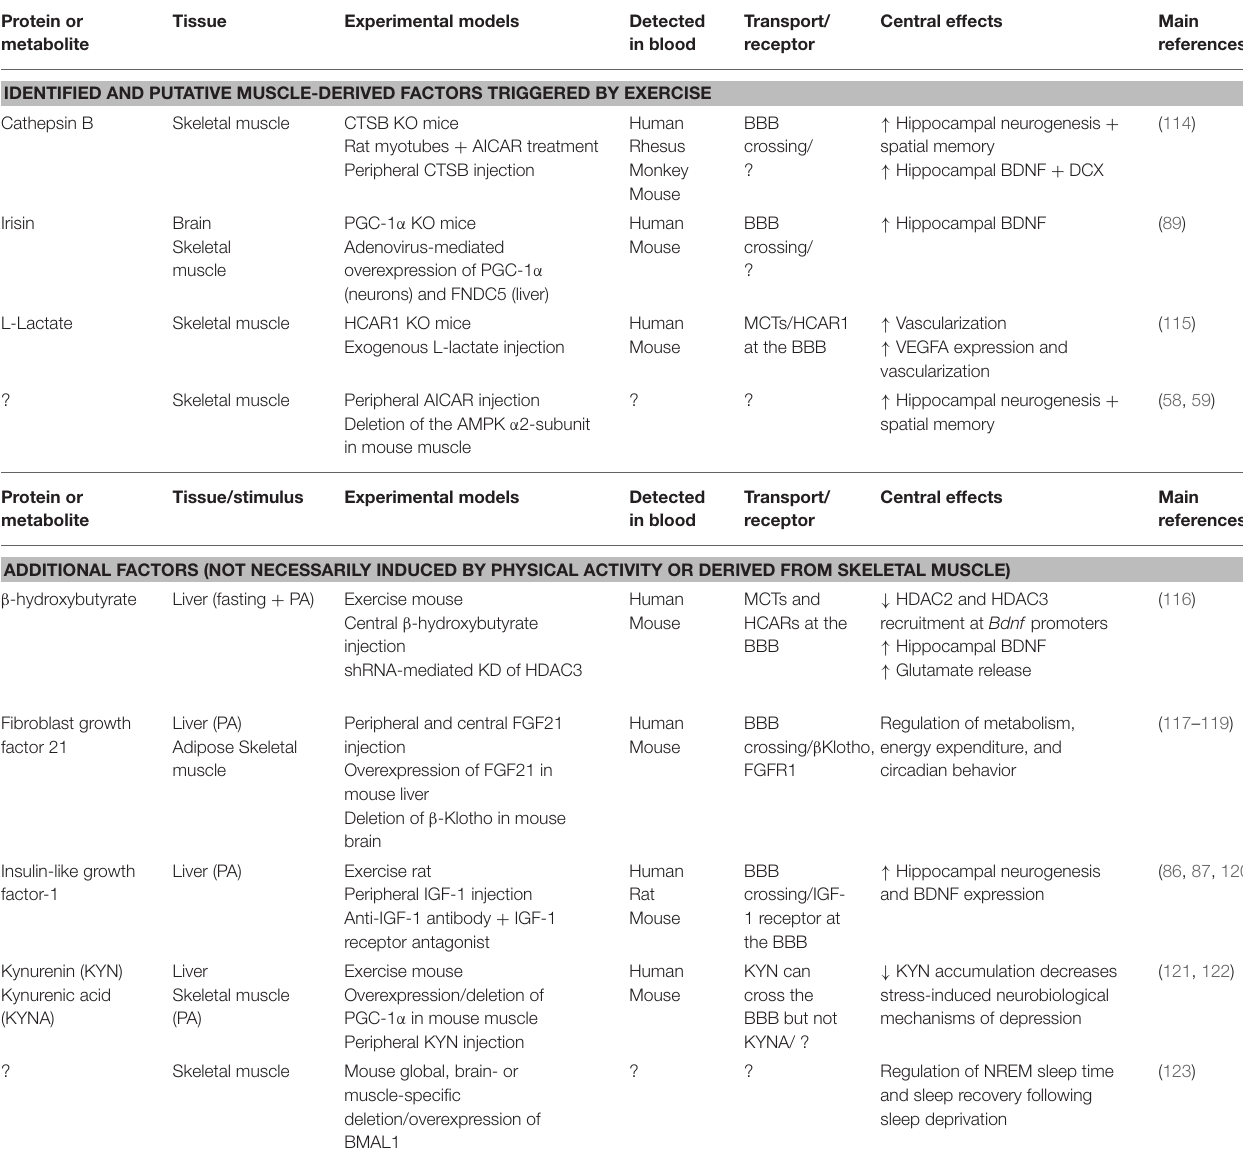
TABLE 1 | Overview of muscle-derived and exercise-induced endocrine signals involved in the periphery-brain crosstalk. Protein or